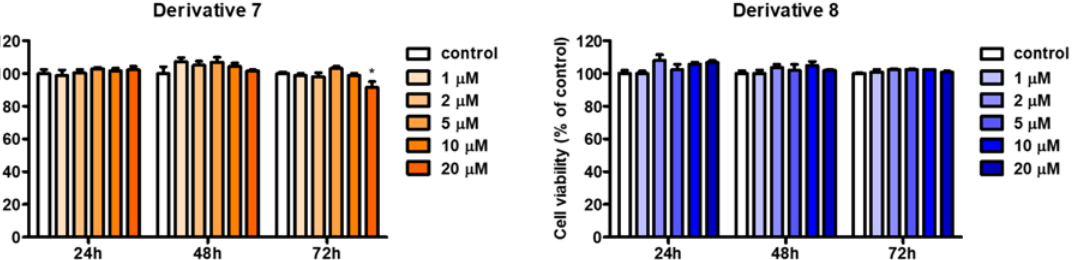
Figure 7. Cell viabilities of BABT derivatives 7 and 8 in B16F10 cells at three time points (24, 48, and 72 h).